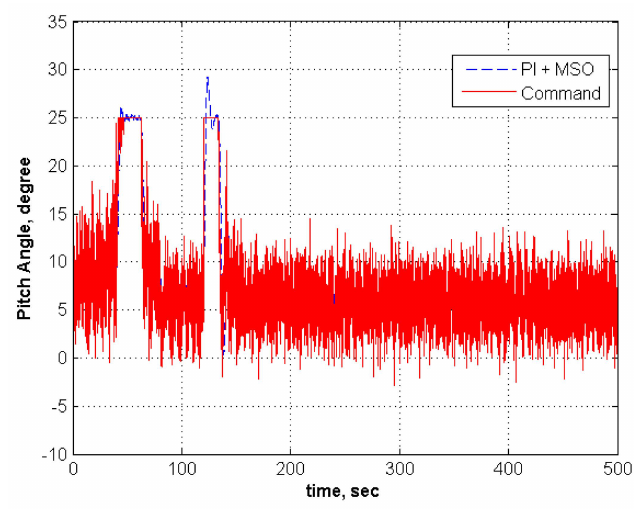
Figure 5. Pitch angle response for 100% C m α .